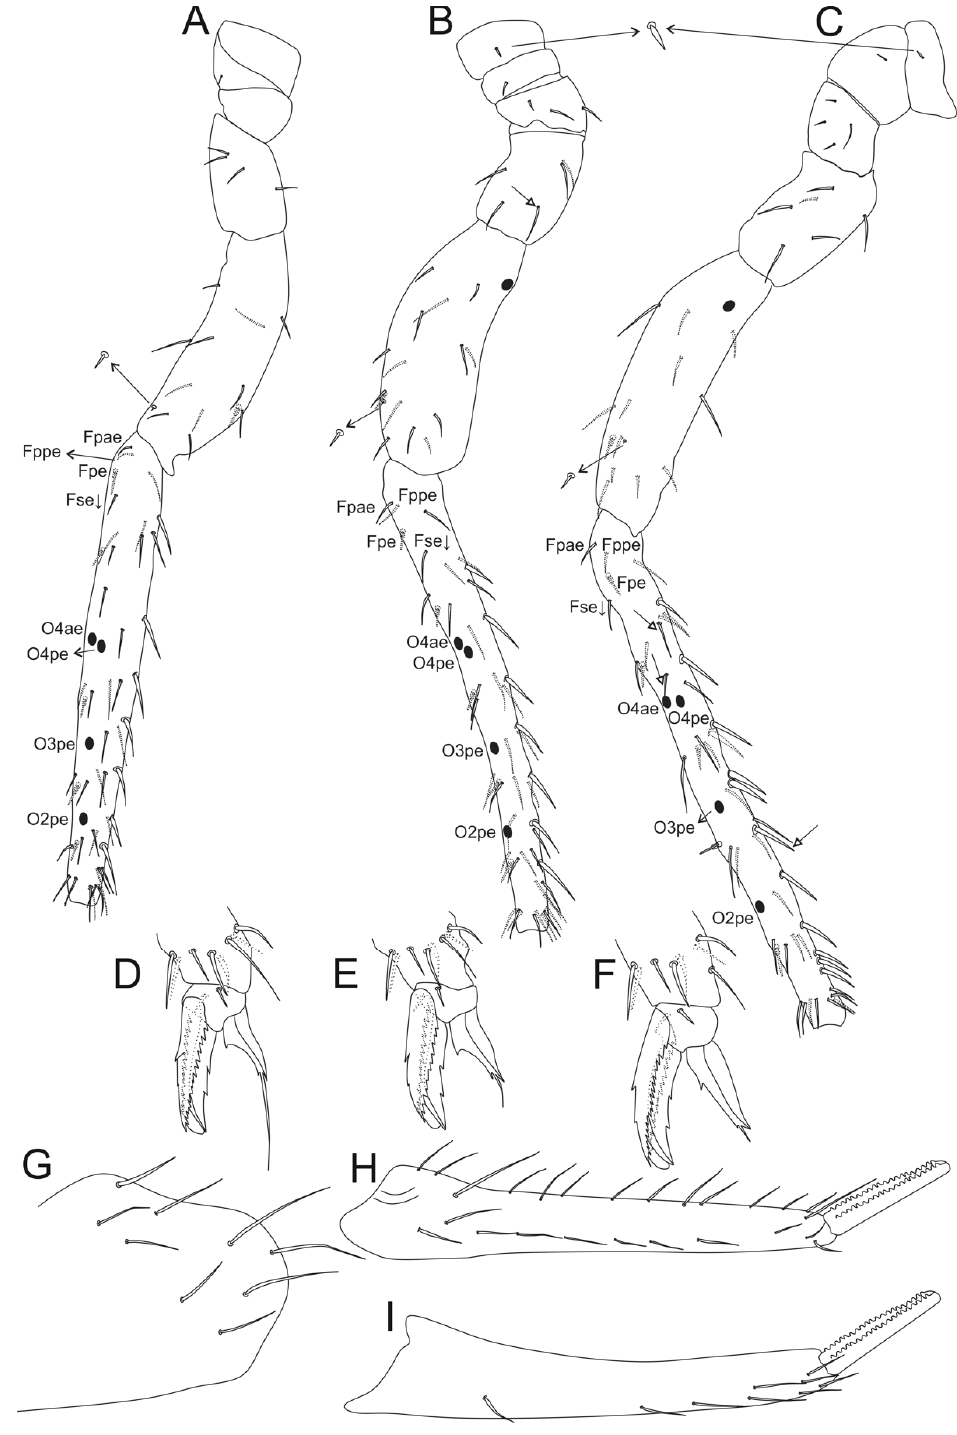
Figure 21. Calvatomina gladiata sp. nov. legs and furcula: ( A – C ) leg I–III, respectively (anterior view), black circles indicate oval organs, white arrows indicate chaetae present or absent, in detail micro and acanthoid chaetae; ( D – F ) empodial complexes I–III, respectively (anterior view); ( G ) manu ‐ brium (dorsal side); ( H ) dorsal dens chaetotaxy and mucro (inner view); ( I ) ventral dens chaetotaxy and mucro (outer view).